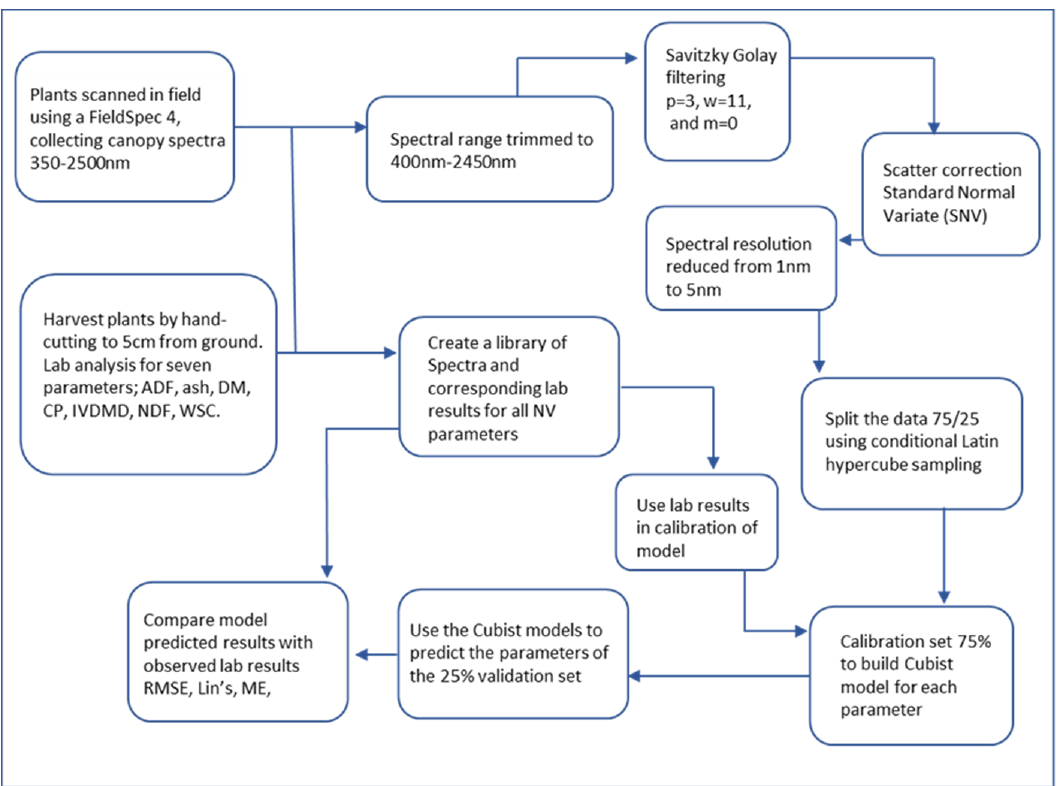
Figure 2. Schematic diagram of spectral data collection and nutritive value (NV) assessment pipeline used for model development to predict acid detergent fibre (ADF) 1964, ash, dry matter (DM), crude protein (CP), in vivo dry matter digestibility (IVDMD), neutral detergent fibre (NDF), and water-soluble carbohydrates (WSC.